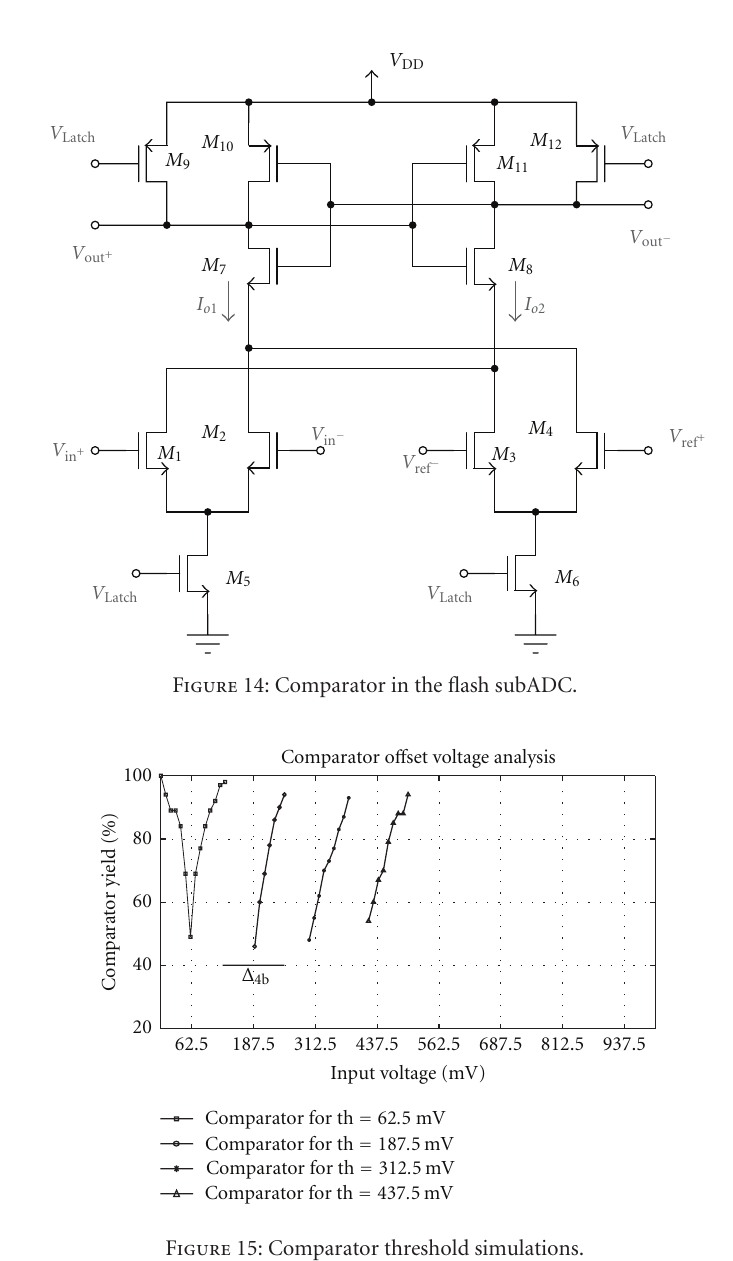
Figure 15: Comparator threshold